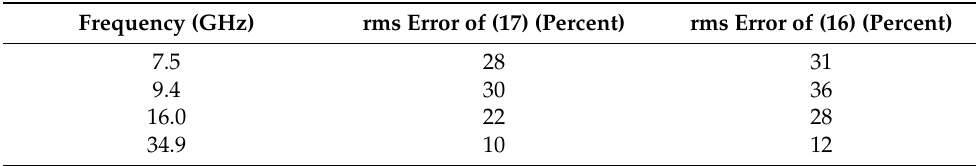
Table 1. The root mean square(rms) error of the linear model in Equation (16) and the logarithmic model in (17)